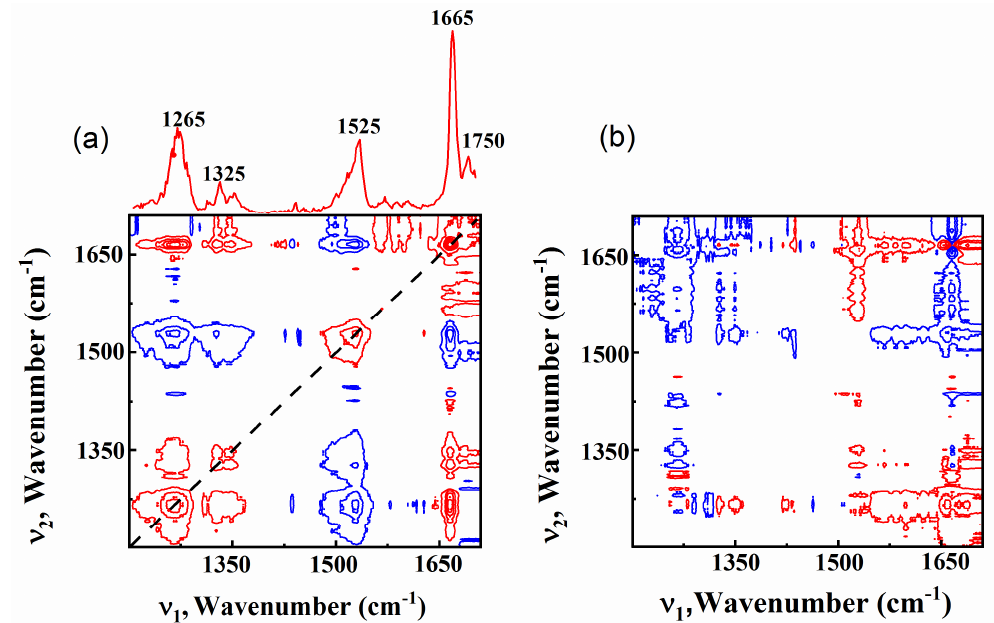
Figure 4. Synchronous ( a ) and asynchronous ( b ) 2D correlation spectra obtained from the series of 1D Raman spectra. Red and blue colors represent positive and negative peaks, respectively. The auto correlation spectrum extracted along the diagonal line in synchronous 2D correlation spectrum is shown at the top of Figure 4a.